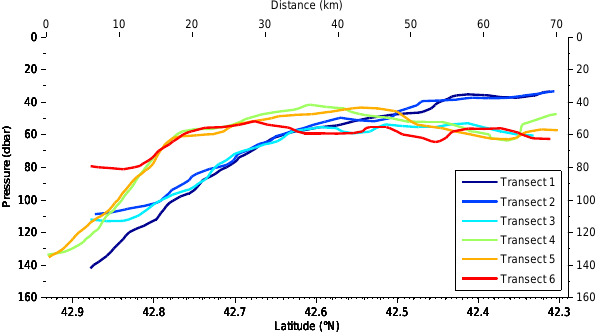
Figure 7. Potential density anomaly σ(z) = 28 . 7kgm − 3 isopycnal evolution color coded for each glider transect.